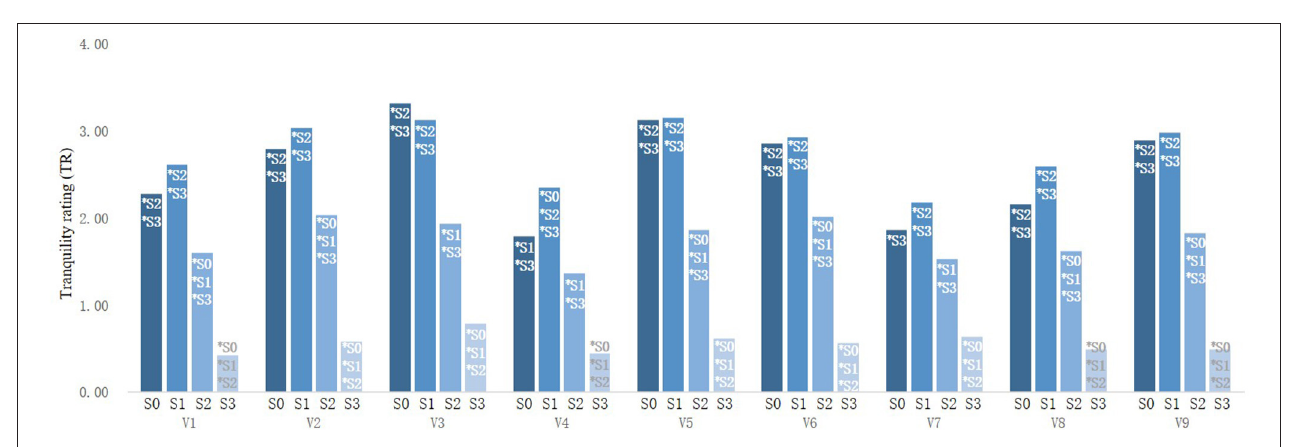
FIGURE 7 | Comparison of street TR under different sound